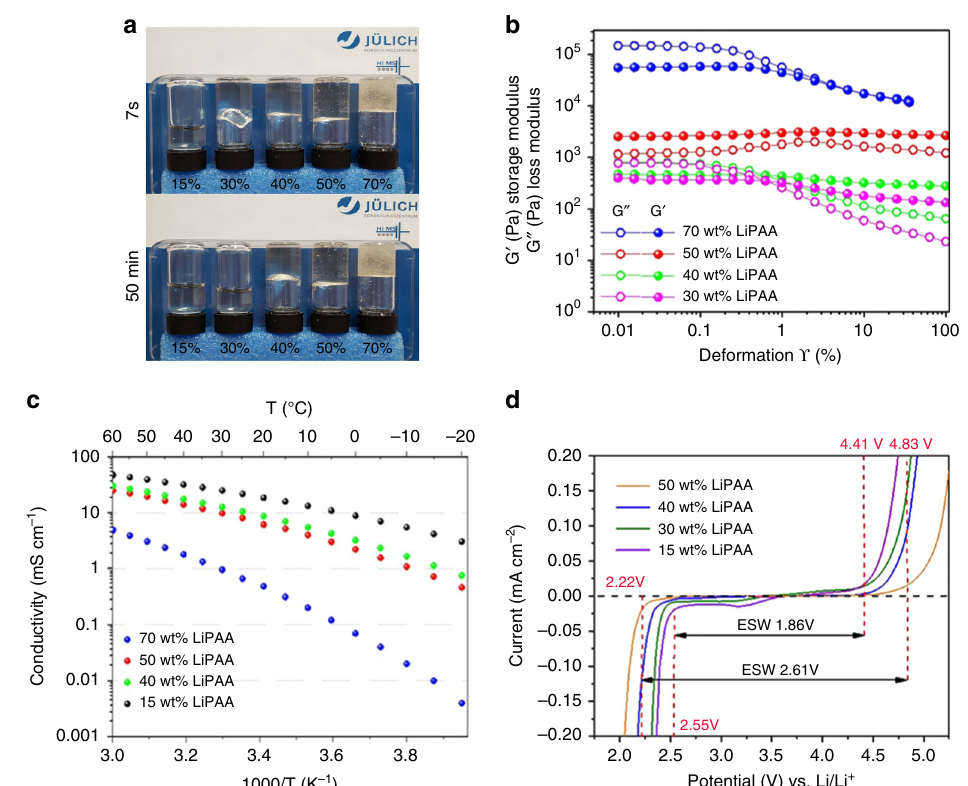
Fig. 1 Mechanical and electrochemical properties of the electrolytes. a Appearance of LiPAA aqueous electrolytes 7 s and 50 min after fl ipping the fl asks. b Storage and loss moduli of the gel electrolytes (from 30 wt% to 70 wt% LiPAA). c Arrhenius plot of the conductivities of the electrolytes. d Electrochemical stability window with Pt as the working electrode, scan rate: 0.1 mV s −